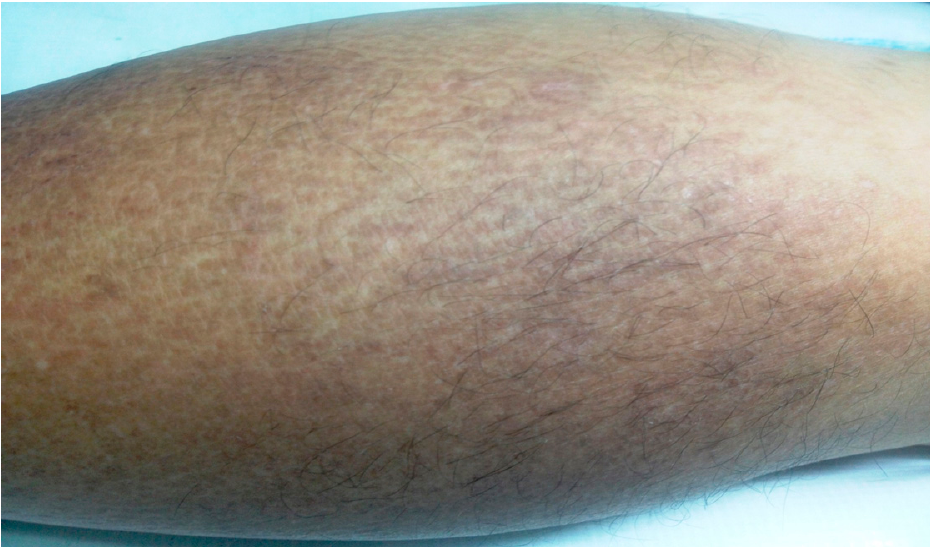
Figure 1. Clinical image showing brownish macules with a rippled pattern on the lower leg.